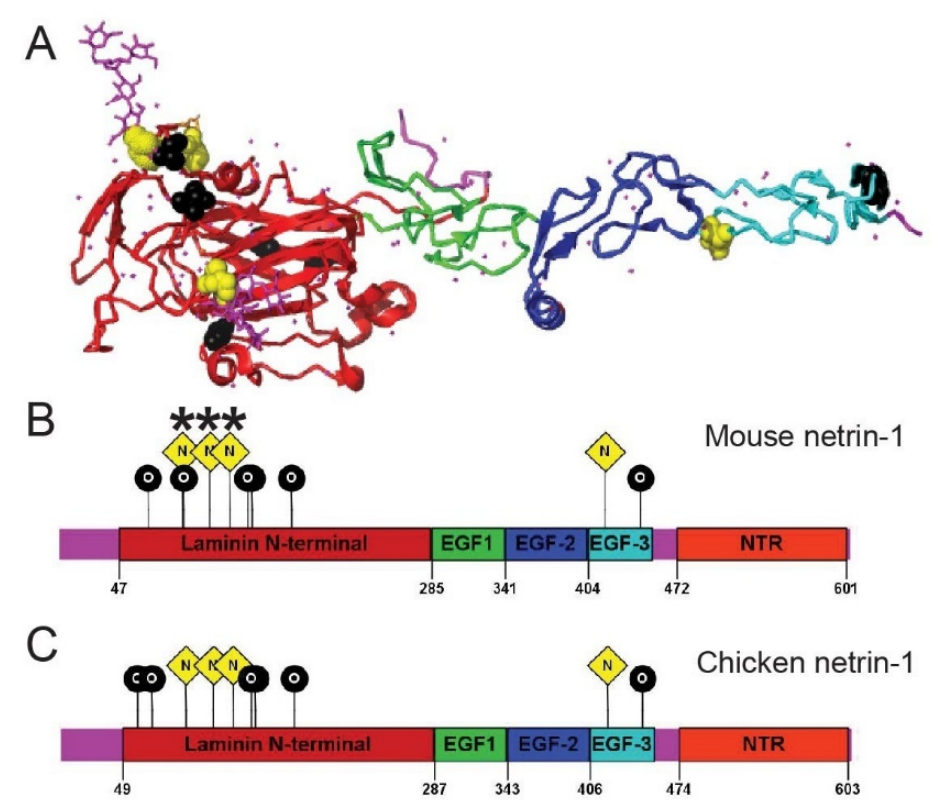
Figure 3. Glycosylation sites prediction of netrin-1 ( A ) Crystal structure of mouse netrin-1 generated using PyMOL using PDB files obtained from UniProt. Glycosylation sites predicted from GlycoMine struct [92] are presented with black and yellow spheres in crystal structure. Yellow and black spheresindicate N-linked (probability more than 0.8) and l O-linked (probability more than 0.95) glycosylation sitesrespectively. ( B , C ) Domain organization of mouse ( B ) and chicken ( C ) netrin-1 with predicted glycosylations sites. N-linked glycosylation sites known from the crystal structure are marked with asterisks (N91, N116, and N131). Color code of domains is consistent with structure shown in A (NTR domain is not represented in A).